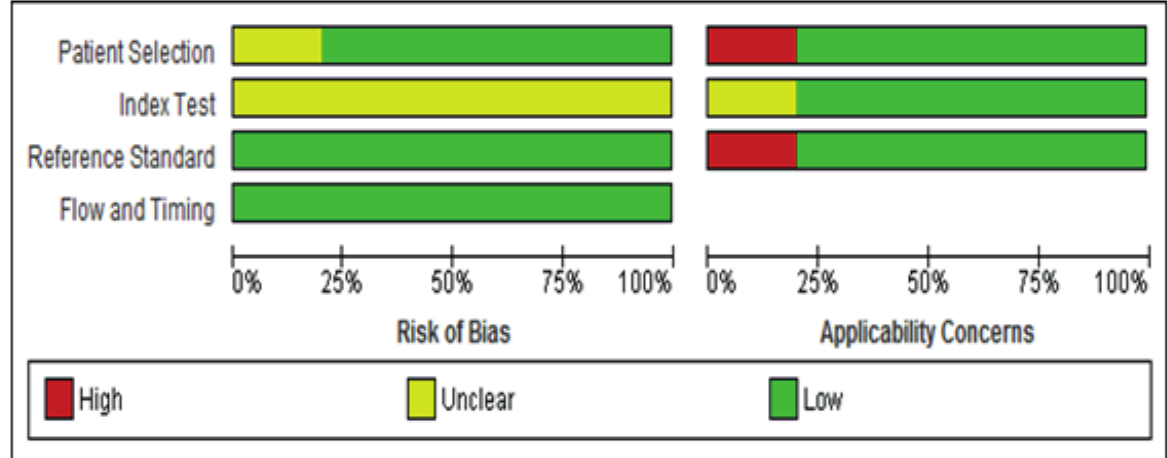
Figure 2 - QUADAS-2 – Risk of